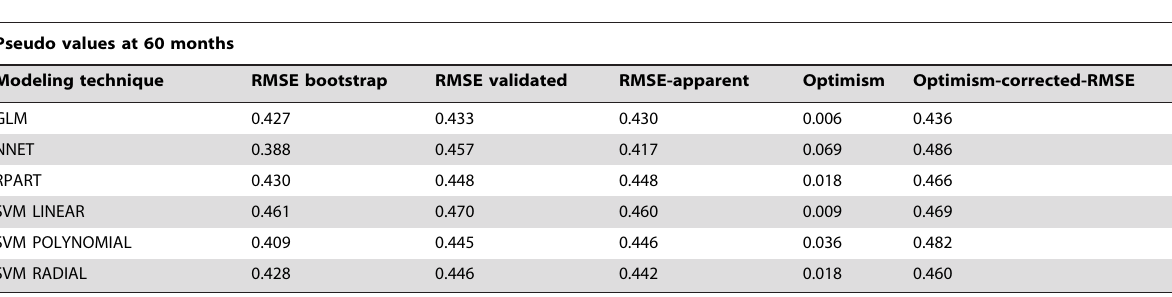
Table 4. Performance of models for the outcome ‘pseudo values at 60 months’.